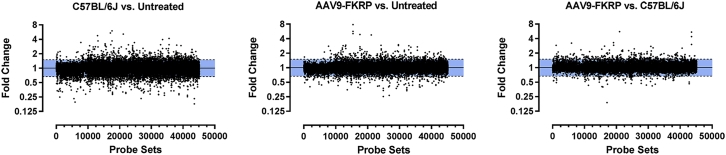
Distribution of the Calculated Expression LevelsFold change (log2 ratio) calculated from the total probe sets contained in the GeneChip MG-430 PM array strip and subjected to tibialis anterior muscle samples (n = 4) derived from their respective mouse cohort: C57BL/6J versus untreated FKRPP448L (left), AAV9-FKRP-treated (5 × 1013 vg/kg) versus untreated FKRPP448L (middle), and AAV9-FKRP-treated (5 × 1013 vg/kg) versus C57BL/6J (right). Probe sets that were calculated to have a log2 ratio intensity greater than 1.5 or lower than 0.666667 were recognized as overexpressed and underexpressed, respectively, and are located outside the shaded blue region.